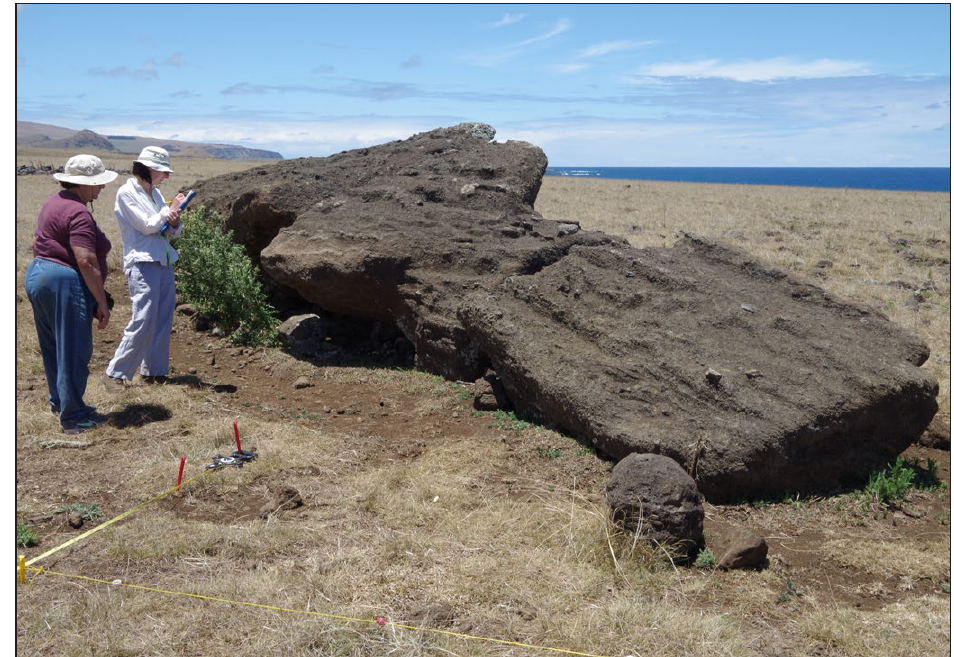
Figure 3: The profoundly weathered and eroded rear of “Cook’s moai ” on the southern Ara Moai . The flow lava inclusions projecting from the tuff give an idea how much material has been lost. Differential weathering of the moai ’s downward side (not visible in the photo) shows that it was once standing. Photo: Mike Seager